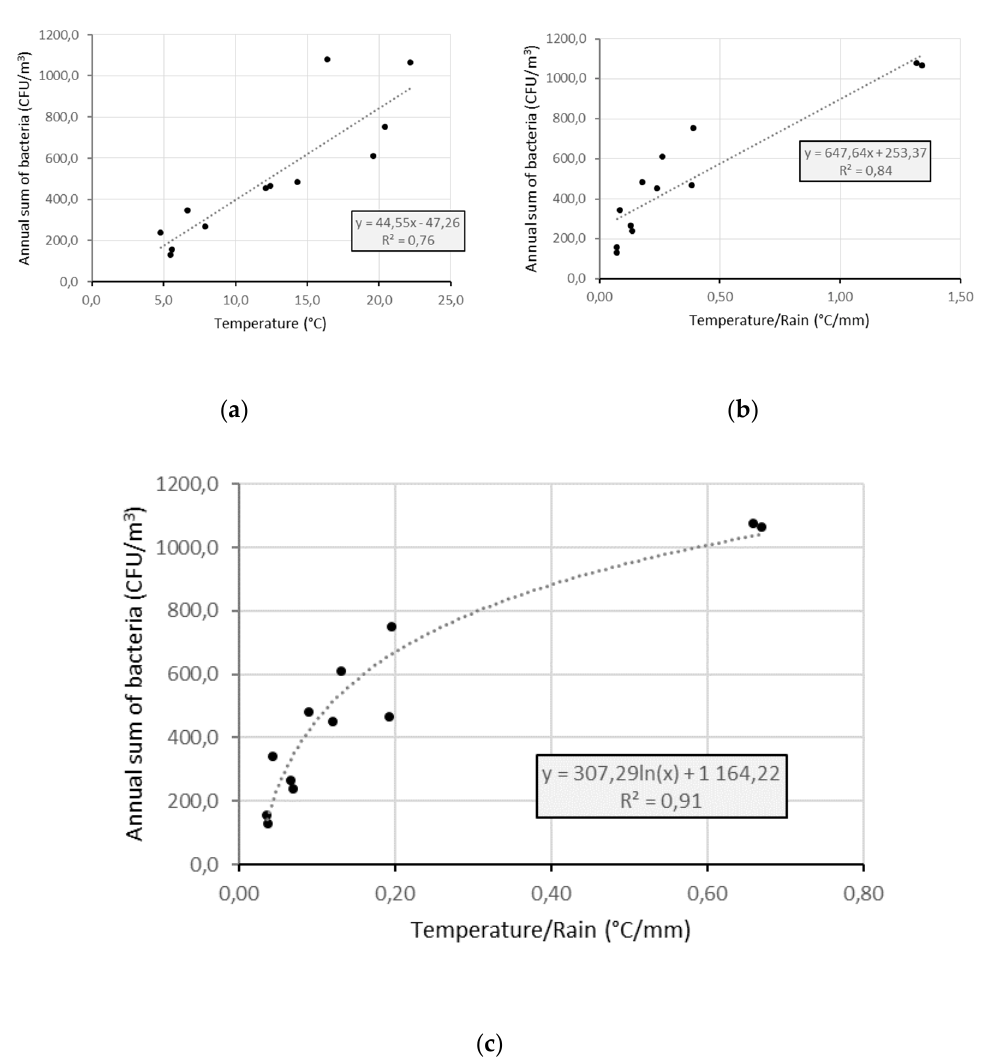
Figure A6. Linear regression of Temperature (°C) and CFU/m 3 ( a ) and ratio Temperature/Rain and CFU/m 3 ( b ), logarithmic regression CFU/m 3 and ratio Temperature/Rain and CFU/m 3 ( c ).